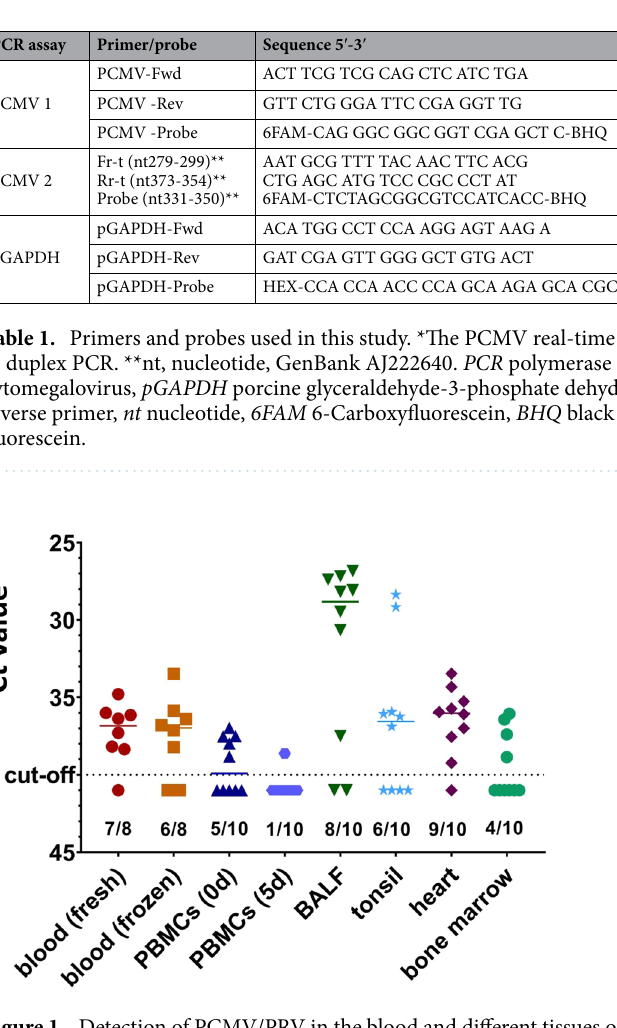
Figure 1. Detection of PCMV/PRV in the blood and different tissues of ten 9 weeks old piglets by real-time PCR. The number of positive/tested animals is indicated. PBMCs, peripheral blood mononuclear cells; PBMCs were tested at day 0 (0d) and after 5 days (5d) cultivation, BALF, bronchoalveolar lavage fluid.